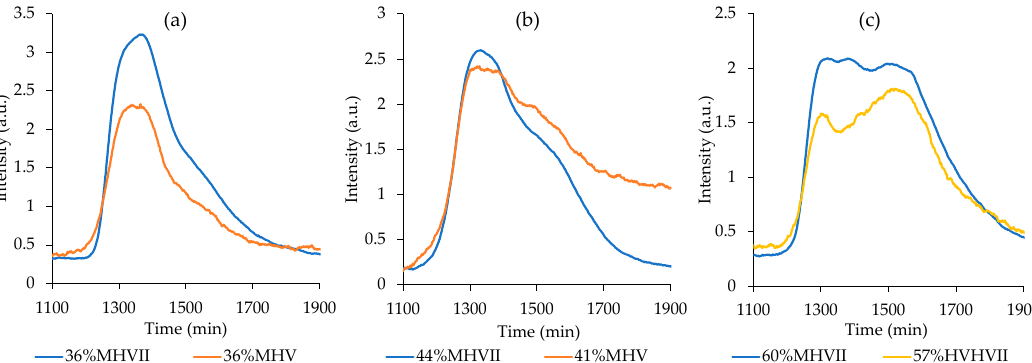
Figure 4. GPC spectra of starch mixtures after IL treatment: ( a ) samples with a 36 wt% of amylose prepared from Maize + Hylon V (orange) and Maize + Hylon VII (blue), ( b ) samples with a 41 and 44 wt% of amylose prepared from Maize + Hylon V (orange) and Maize + Hylon VII (blue), respectively, and ( c ) samples with a 60 and 57 wt% of amylose prepared from Maize + Hylon VII (blue) and Hylon V + Hylon VII (yellow), respectively.